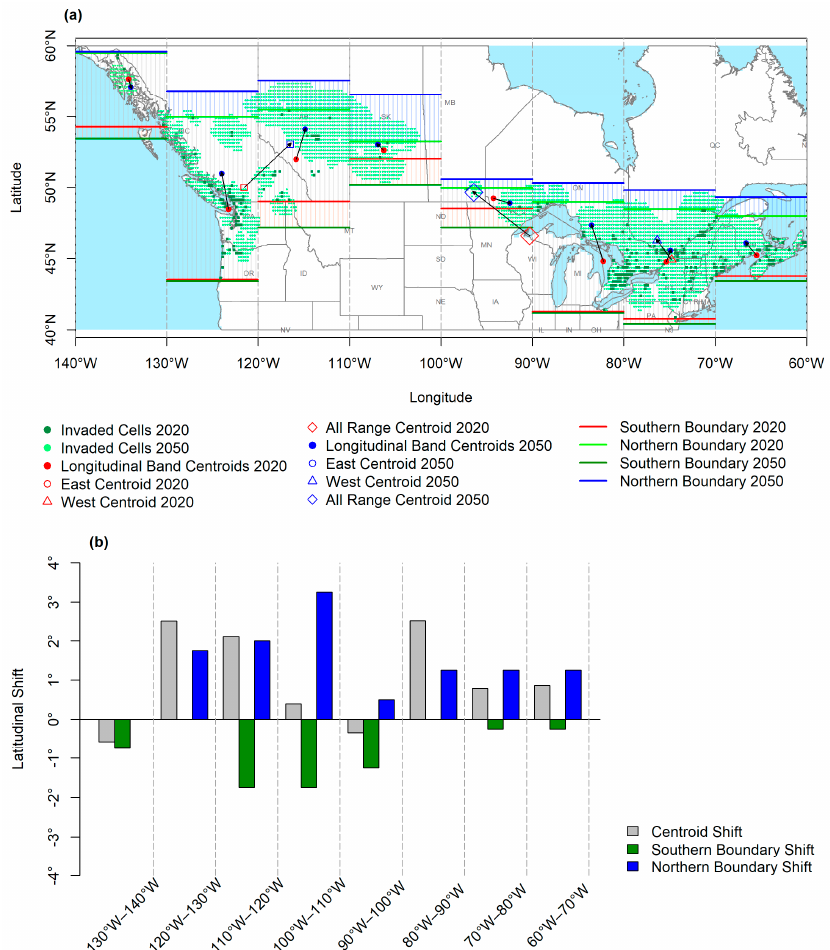
Figure 6. Shifts of centroids and boundaries for 10 ◦ longitudinal bands. ( a ) Initial (2020) and final (2050) centroids and northern/southern boundaries. The black arrows show the shift direction of the centroids. ( b ) Zero-centered shifts of centroids and southern/northern boundaries. Positive values of the y axis represent northward, negative values of the y axis represent southward shifts.